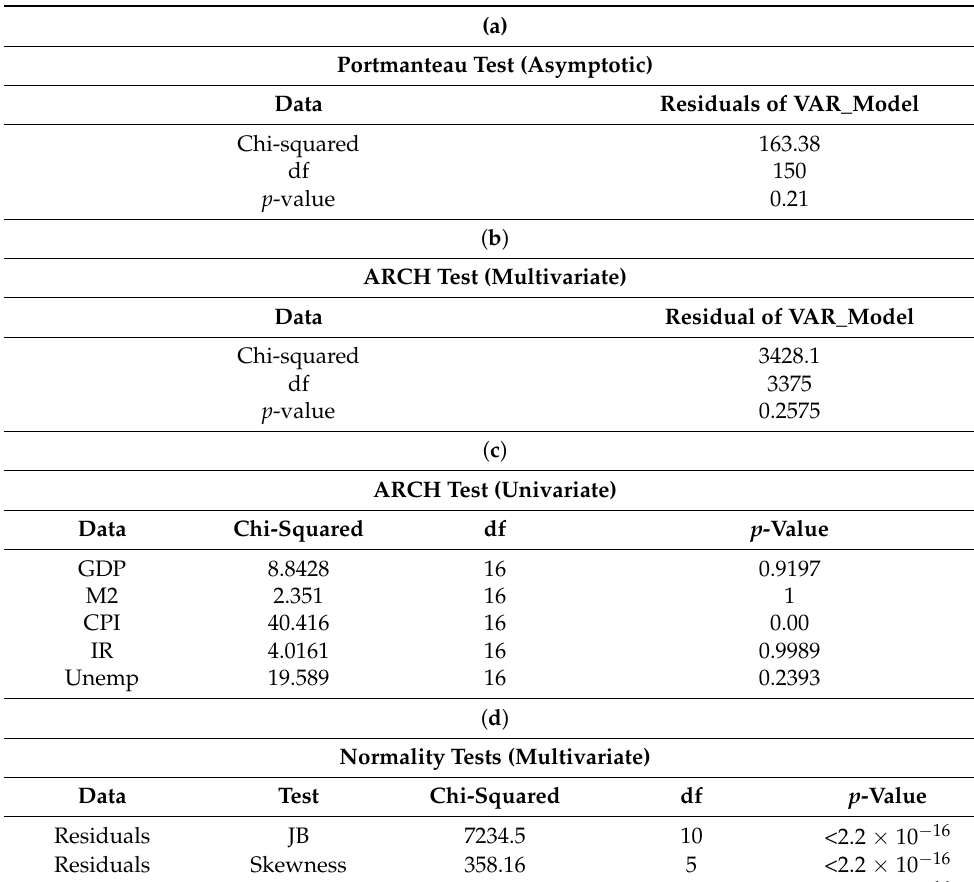
Table 10. ( a ) Portmanteau test output, ( b ) Autoregressive Conditional Heteroskedasticity, ( c ) Autore- gressive Conditional Heteroskedasticity test per variable, and ( d ) Normality test of